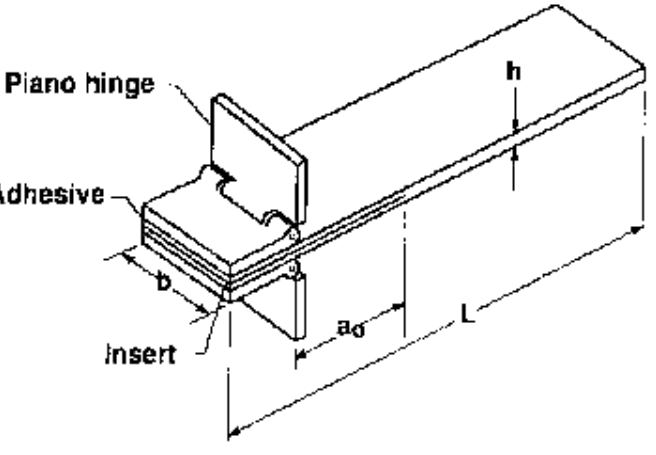
Figure 2. Specimen geometry according to ASTM D5528. Table 1. Specimen dimensions according to ASTM D5528.